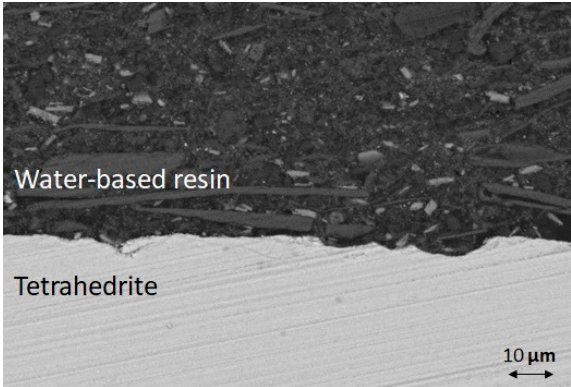
Figure 8. SEM image of cross-section of water-based resin THD coated after curing at 250 °C for 45 min under flowing Ar.